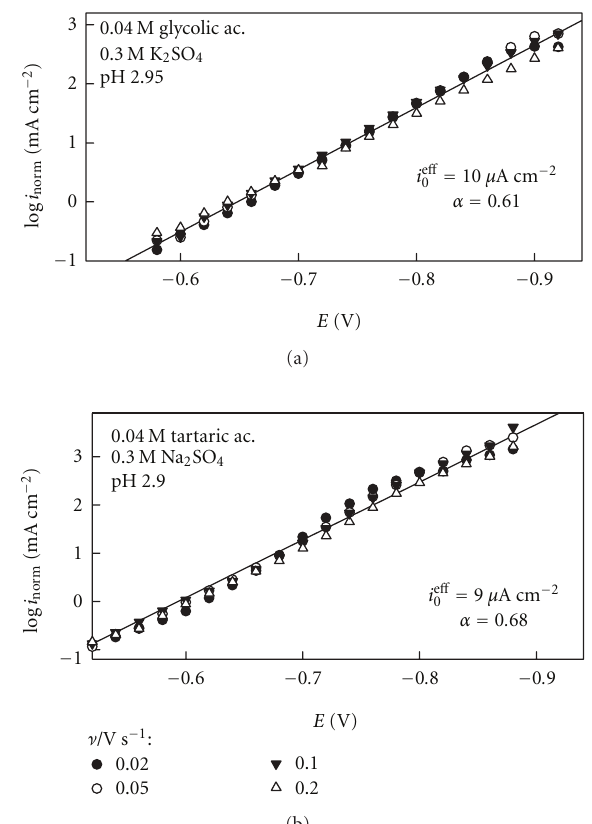
Figure 8: Normalized Tafel plots obtained at di ff erent potential sweep rates for 0.04 M glycolic (a) and tartaric (b) acid solutions. Indicated kinetic parameters are calculated from general regression lines.